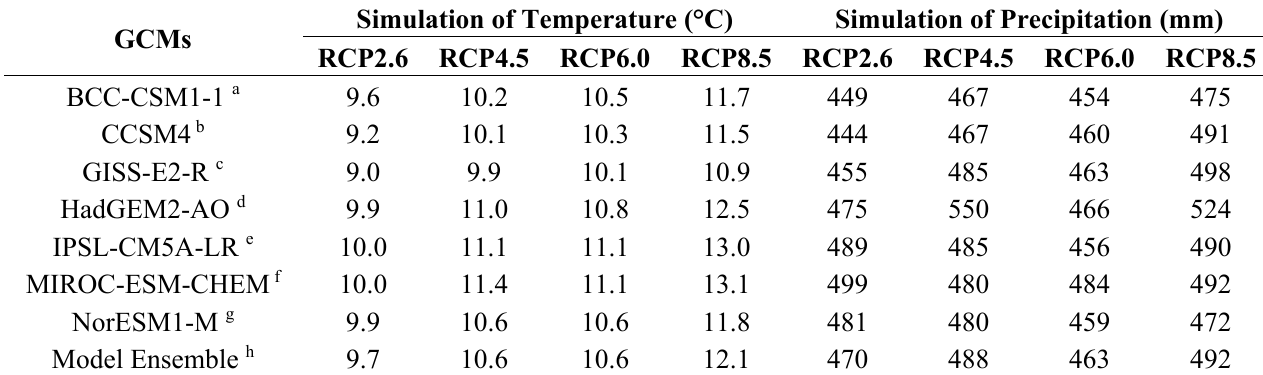
Table 1. Summary of future climate change scenarios (2070s) from seven global climate models (GCMs) on Loess